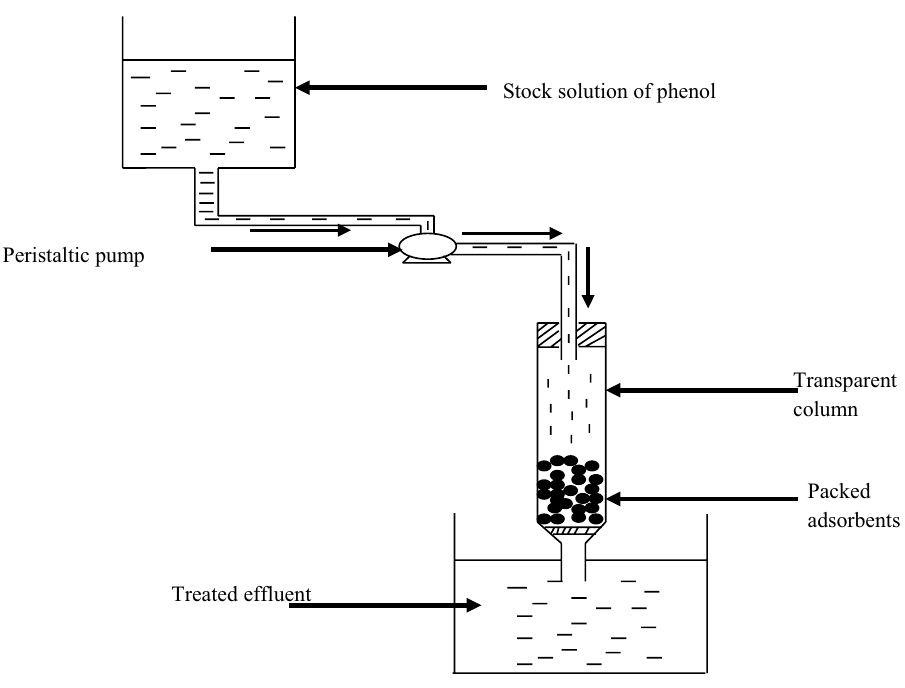
Fig. 1 Schematic diagram for packed bed adsorption process